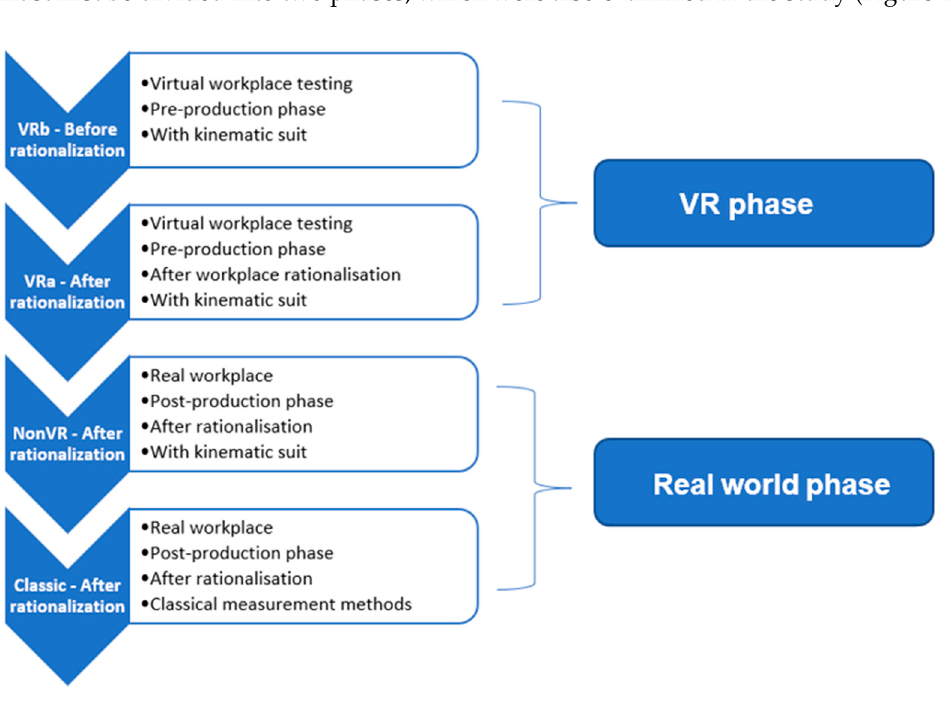
Figure 4. The method of ergonomic rationalisation. The diagram shows the four phases of the study: VRb, VRa, NonVR, and Classic which are described in more detail below.